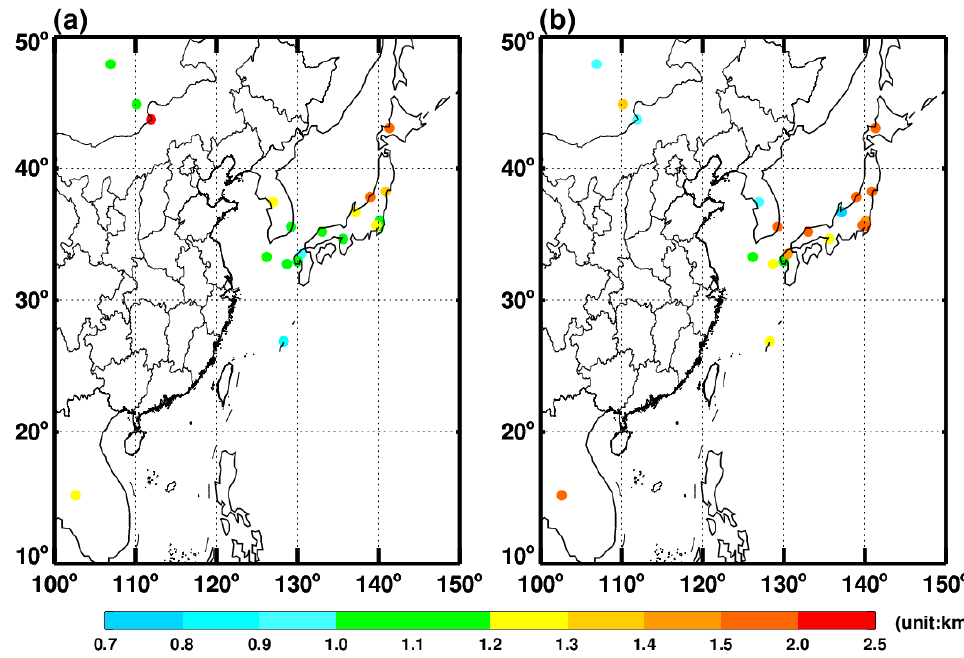
Figure 4. Spatial patterns of 3-year seasonal mean BLH for 20 sites in AD-Net over East Asia from the AD-Net for summer ( a ) and winter ( b ). Table 1. BLH derived from AD-Net over inland and ocean area.